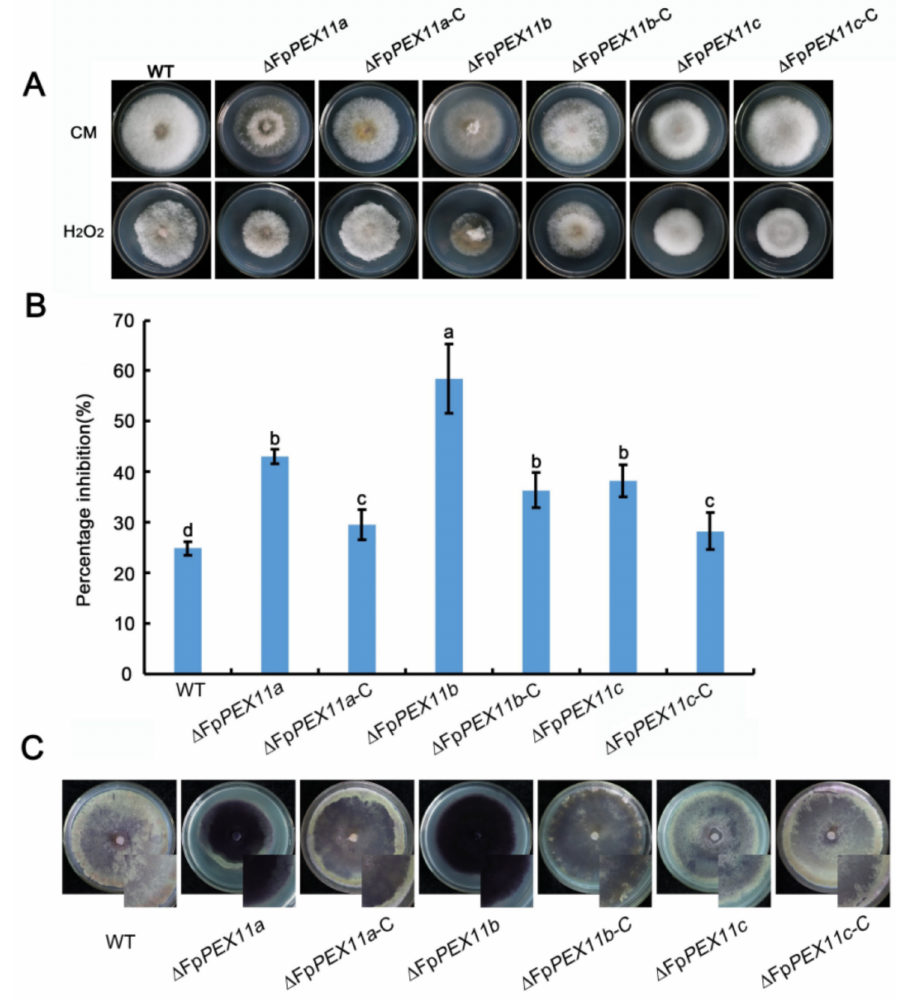
Figure 4. Sensitivity to H 2 O 2 and ROS accumulation. ( A ) Strains were grown on complete medium (CM) supplemented with H 2 O 2 . ( B ) Mycelial growth inhibition. ( C ) Nitroblue tetrazolium (NBT) staining for ROS production in mycelia of strains. Different letter on the bars for each treatment indicate significant difference at p < 0.05 by Duncan’s multiple range